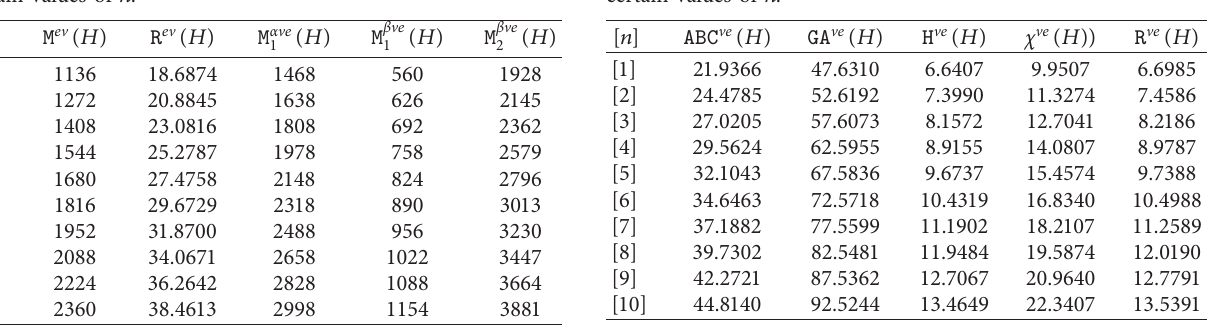
Figure 9: (a) M ev , M α ve , M β ve , and M β ve . (b) ABC ve , GA ve , H ve , and χ ve . (c) R ev and R ve . 1 2 1 Table 10: Numerical representation of the computed indices for certain values of n